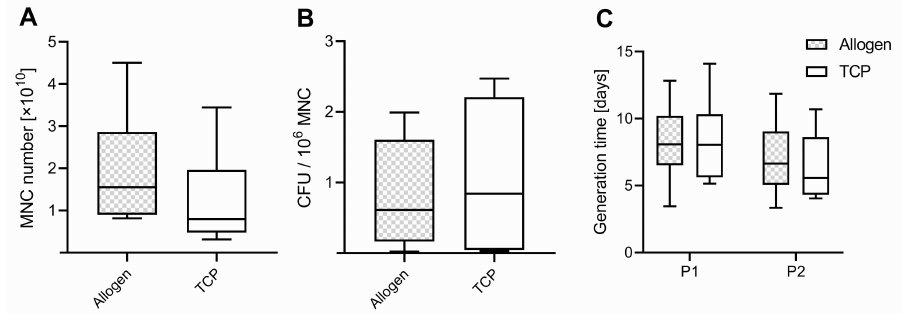
Figure 1. ( A ) Number of mononuclear cells (MNC), ( B ) colony-forming units (CFU) per million MNCs, and ( C ) generation time of passage 1 (P1) and 2 (P2). Boxplots indicate the median within the 25–75%